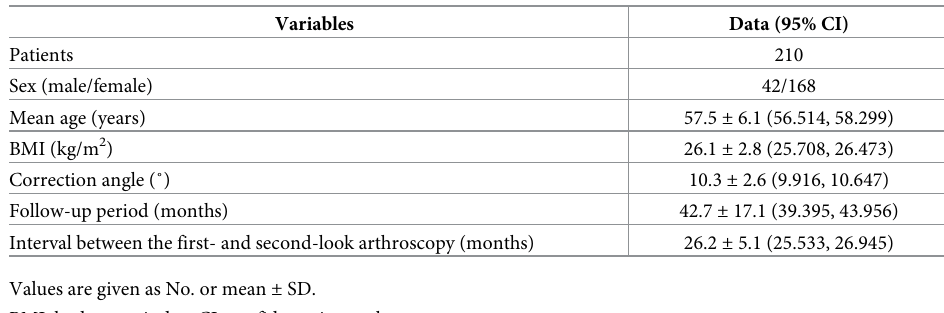
Table 1. Patient characteristics.